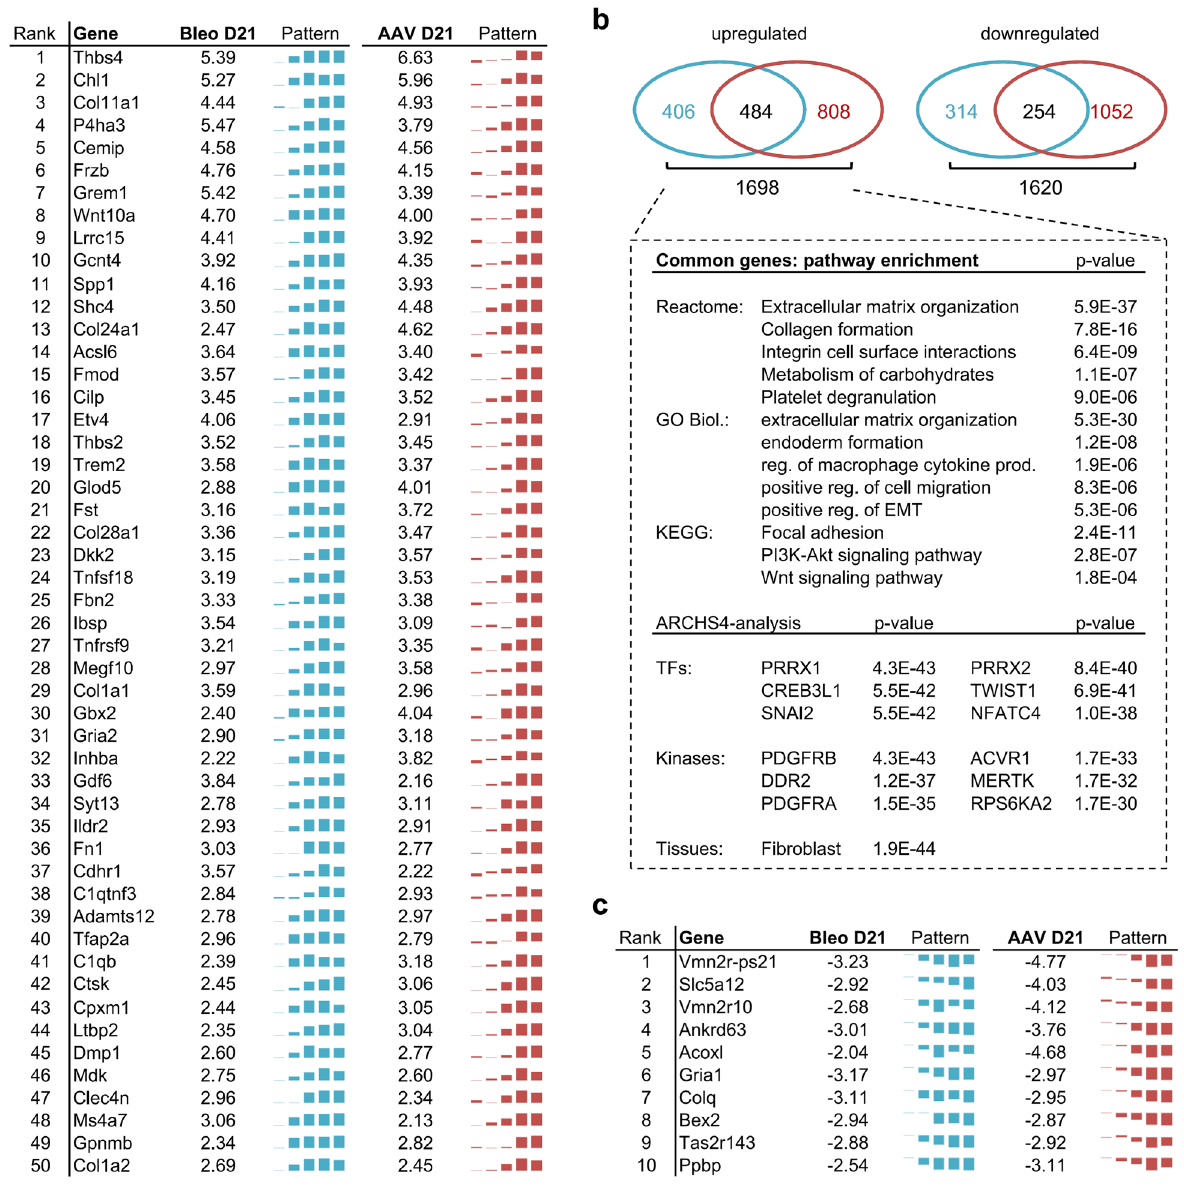
ticular importance during pathogenesis, we focused on genes whose longitudinal expression changes strongly correlated with the observed decline in lung function (Fig. 1i), thereby linking transcriptomic to phenotypic changes. Genes whose expression changes closely paralleled the decrease in lung function (absolute correlation coefficient of ≥ 0.85) were selected and ranked by their mean fold change in expression on day 21 across both models (Suppl. Table 2). The top 50 upregulated (i.e., lung function anti-correlated) and top 10 downregulated (i.e., lung function correlated) genes are presented in Fig. 4a and c, respectively. Known protein interactions